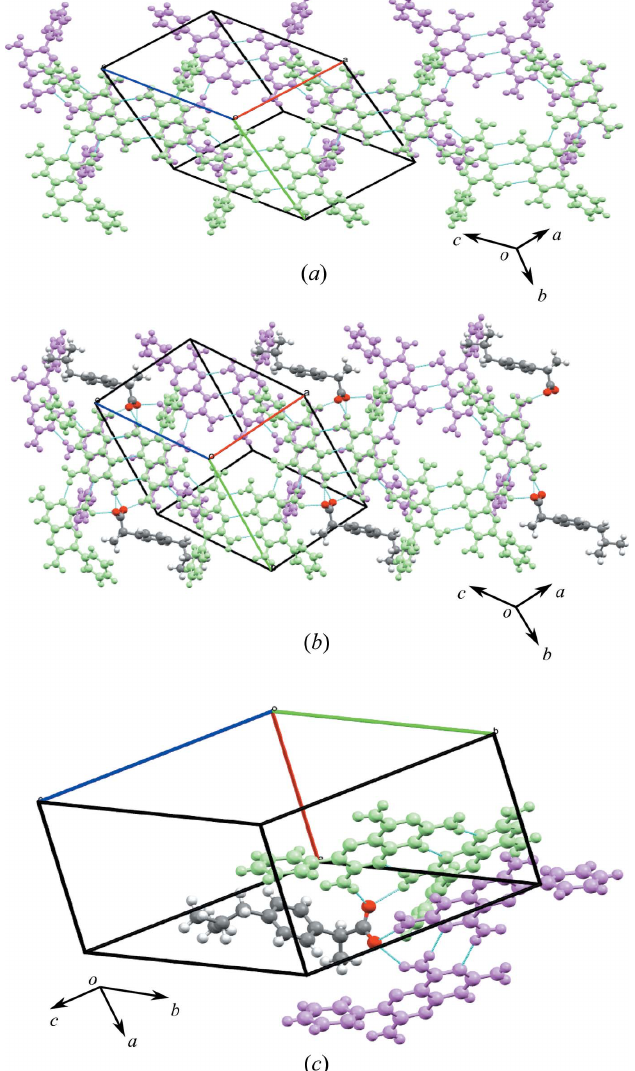
Figure 16 ( a ) Stacking of molecules of 1 , ( b ) the linking of molecules of 1 using molecules of g and ( c ) the specific interactions observed between the stacked hydrogen-bonded layers of 1 and g as seen in the crystal structure of 1g (cid:3)